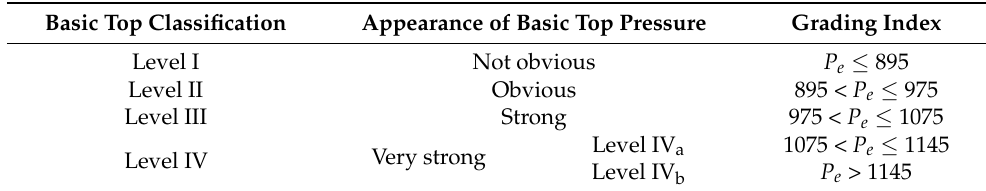
Table 1. Basic top classification index